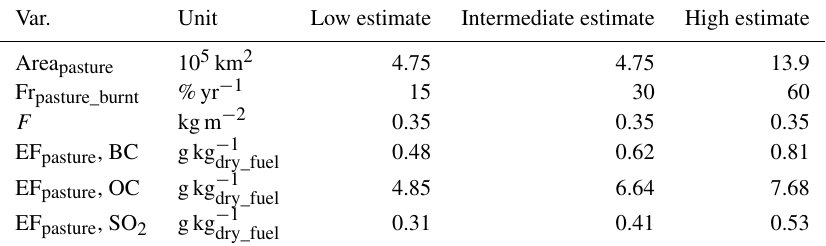
Table 3. The values used to calculate the aerosol emissions from pasture burning (Eq. 6) for the low, intermediate, and high scenarios. Note that the total area of pasture in the study domain (Area pasture ) is shown instead of the fraction per grid box (Fr pasture